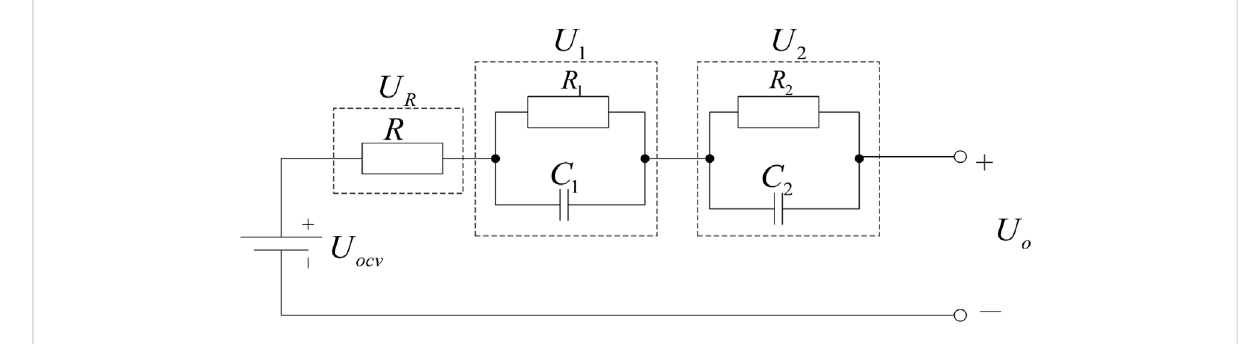
FIGURE 1 The two-order RC equivalent circuit